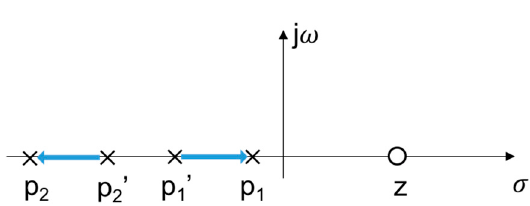
Figure 6. Miller compensation.